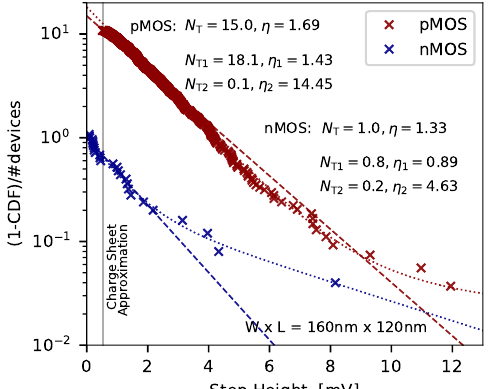
Figure 13. The complementary cumulative distribution function (CDF) is shown for nMOS and pMOS SiON transistors of equal active gate area. The insulator thickness is t ox = 2.2 nm for all devices. As can be seen, the complementary CDF reveals two branches for both kinds of transistors. Such a behavior can be well described by Equation (8) (dashed lines consider uni-modal exponential distribution, dotted lines consider bi-modal exponential distribution). Additionally, the maximum step height calculated considering the CSA is also shown (solid black line). As can be clearly seen, the CSA significantly underestimates the effective impact of the single defects on the overall shift of device threshold voltage. Furthermore, it can be seen the number of active traps seems to be higher in pMOS devices compared to the nMOS